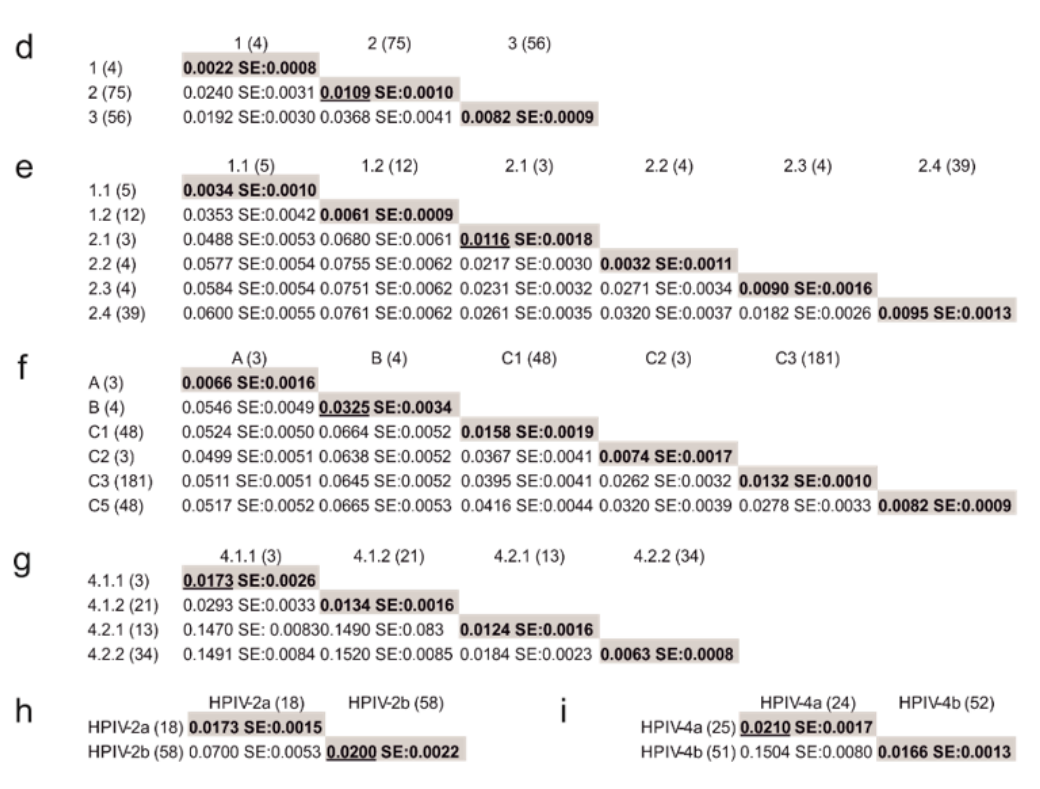
Figure 3. Phylogenetic tree analyses and estimates of average genetic p -distances within and between HPIV clades. Maximum likelihood trees of the partial HN gene are shown for HPIV-1 ( a ), HPIV-2 ( b ), and HPIV-4 ( c ). German sequences of this study are colored by epidemic season: 2015/16 in blue, 2016/17 in red, 2017/18 in orange, and 2018/19 in green. Clades are indicated on the right. Only bootstrap values ≥ 80% are displayed at the branch nodes. Genetic p -distances were calculated for genetic clades of HPIV-1 ( d ), HPIV-2 ( e ), HPIV-3 ( f ), and HPIV-4 ( g ), as well as for genetic groups of HPIV-2 ( h ) and HPIV-4 ( i ). The number of sequences of each clade or group is included in parenthesis. p -distances within each clade or group are shown with a gray background. The highest mean intraclade/intragroup p -distance is underlined. The standard error (SE) is shown next to the mean p -distance.* clades defined by [38]; ‘ clades defined by [53]. Table 5. Distribution of German HPIV by Clade/Cluster and epidemic season 1